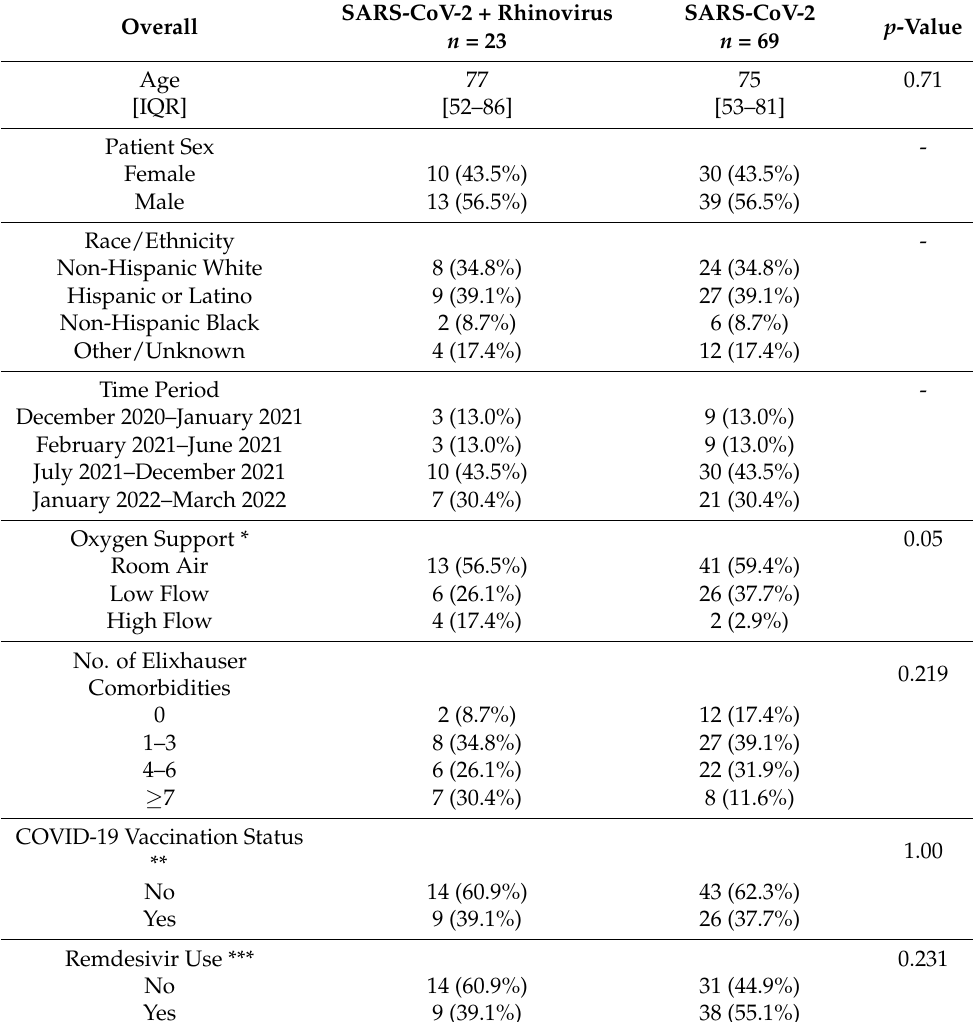
Table 1. Matched cohort of adults with SARS-CoV-2 + rhinovirus infection or SAR-CoV-2 mono-infection. SARS-CoV-2 + Overall